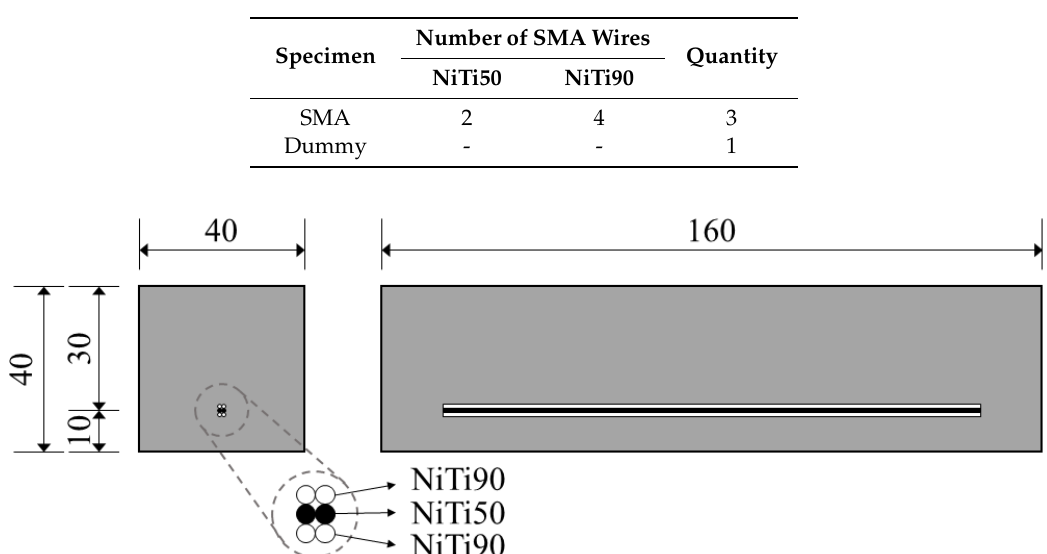
Figure 11. Dimensions of specimen (unit: mm).